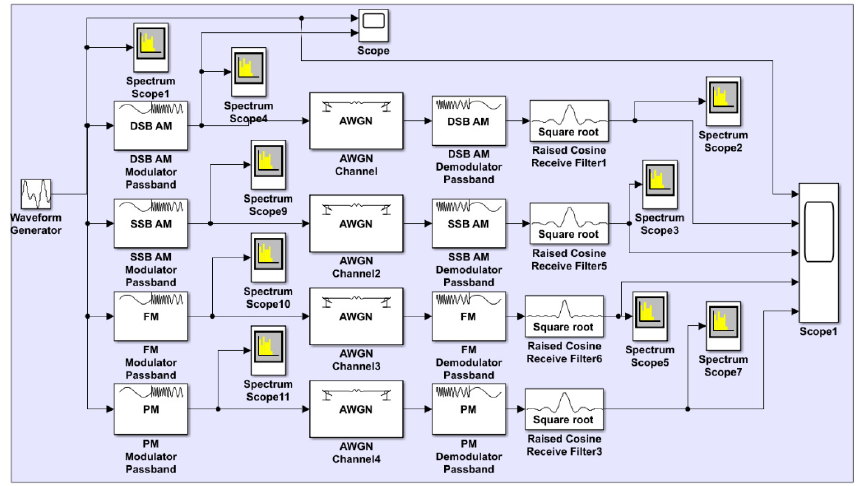
Figure 4. Schematic diagram used in the Matlab-Simulink software for verifying the stability to disturbances of the main emission classes used in search-and-rescue communications at sea.